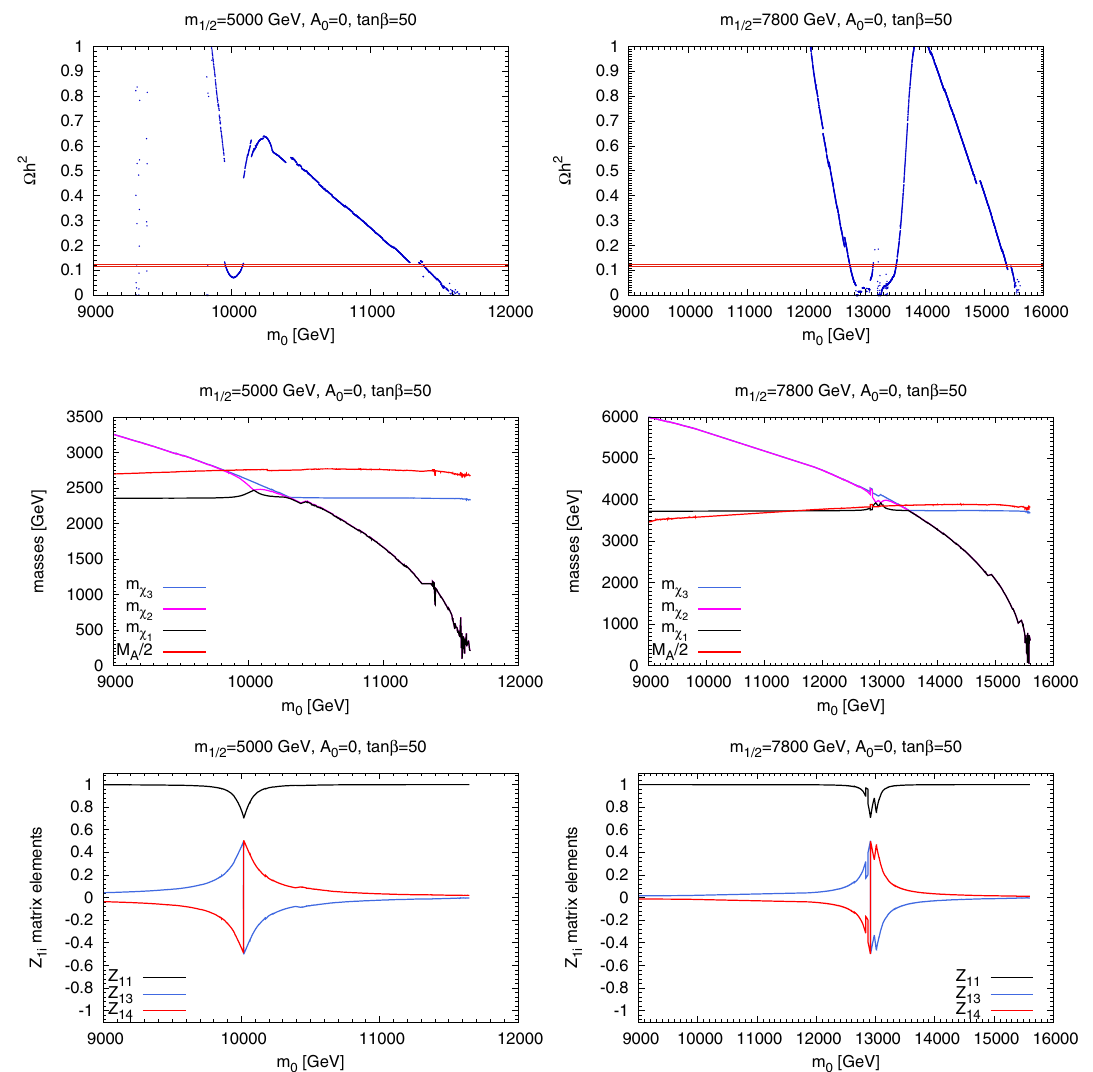
Fig. 3 Cuts across the ( m 1 / 2 , m 0 ) planes for tan β = 50, A 0 = 0 and μ > 0 for varying m 0 and fixed m 1 / 2 = 5 TeV (left panels) and 7 . 8 TeV (right panels), showing the dark matter density (top panels), particle masses (middle panels) and the composition of the LSP (bottom panels)